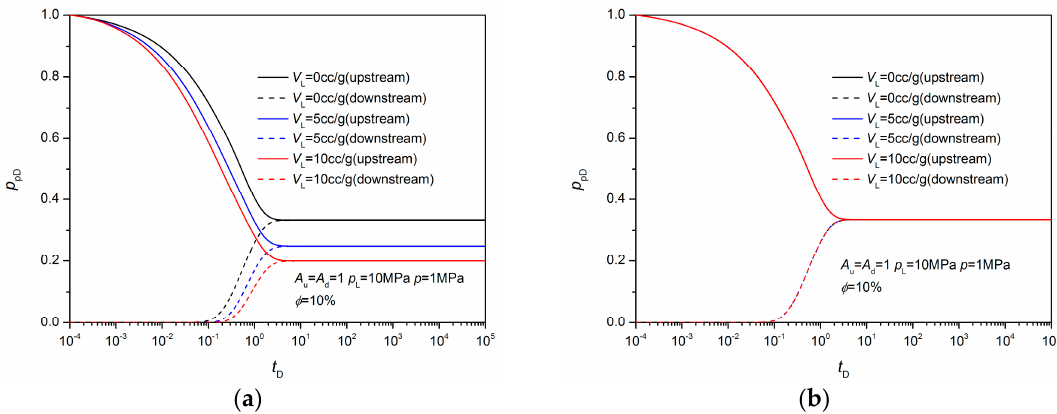
Figure 3. The influence of the Langmuir volume on the pseudo-pressure curves of the equilibrium sorption model. ( a ) Old dimensionless definition. ( b ) New dimensionless definition.